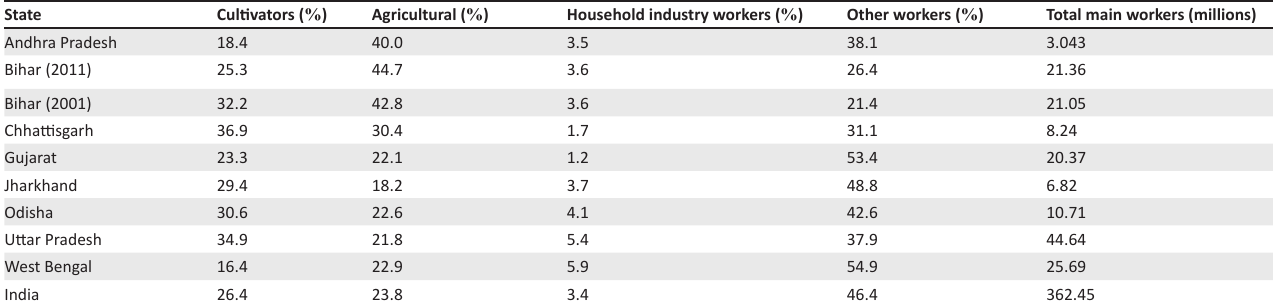
FIGURE 2: Five types of household capital that contribute to household adaptive capacity and resilience. TABLE 1: Composition of main workers in major Indian states, 2011. State Cultivators ( % ) Agricultural ( % ) Household industry workers ( % ) Other workers ( % ) Total main workers